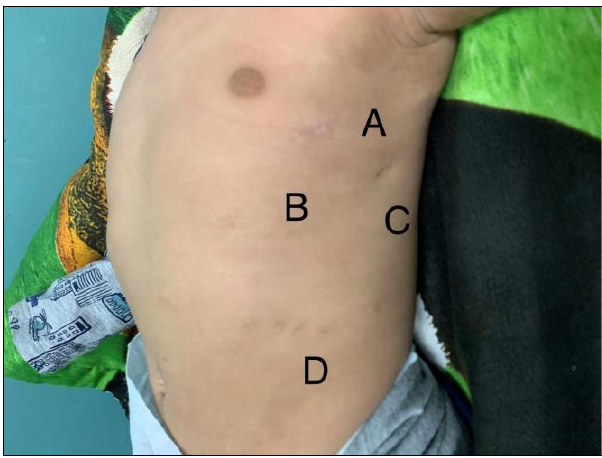
Figure 3: Postoperative figure. A, B, C: Trocar placement sites; D. Reverdin needle